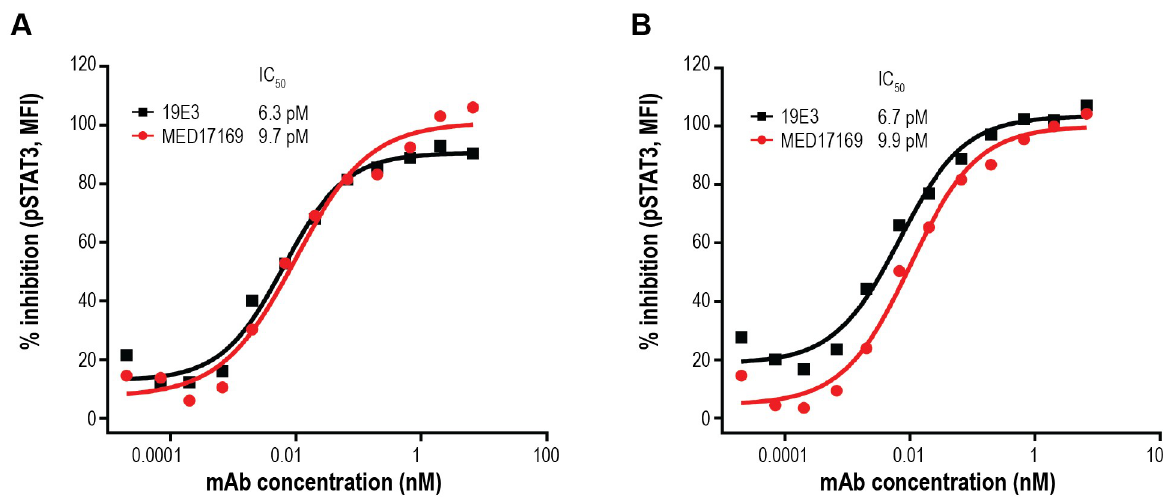
Fig 7. MEDI7169 inhibition of IL-21–induced STAT3 phosphorylation. Human PBMCs were stimulated with recombinant (A) human or (B) cyno IL-21 in the presence of MEDI7169 as indicated. Phosphorylation of STAT3 was assessed by flow cytometry. Percent inhibition of pSTAT3 induction is shown. All conditions were run in duplicate; 1 of 5 representative donors from 4 independent experiments is shown.